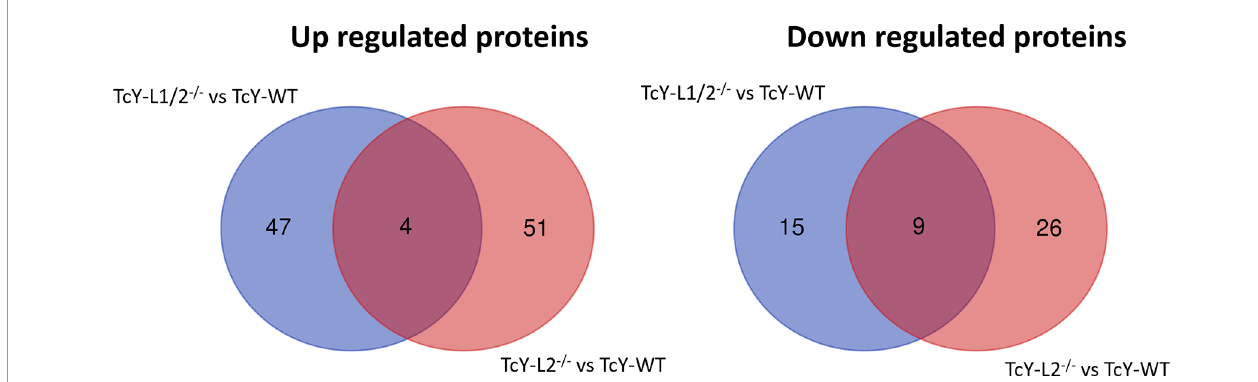
FIGURE 3 | TcY-WT, TcY-L1/2 − / − , and TcY-L2 − / − trypomastigotes present differentially regulated proteins among them. Venn diagrams showing the exclusively regulated and the shared proteins in TcY-L1/2 − / − and TcY-L2 − / − regulated subproteomes in comparison to TcY-WT proteome. This fi gure was prepared using the Draw Venn Diagram webtool (http://bioinformatics.psb.ugent.be/webtools/Venn/).